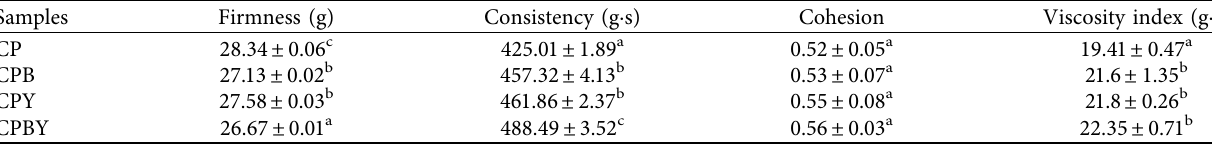
Table 1: The TPA of four samplesof fermented milk.